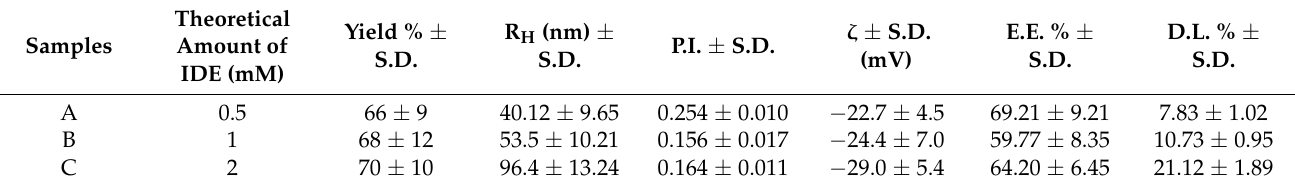
Table 2. Yield %, hydrodynamic radius (R H ), polydispersity index (P.I.), zeta potential ( ζ ),